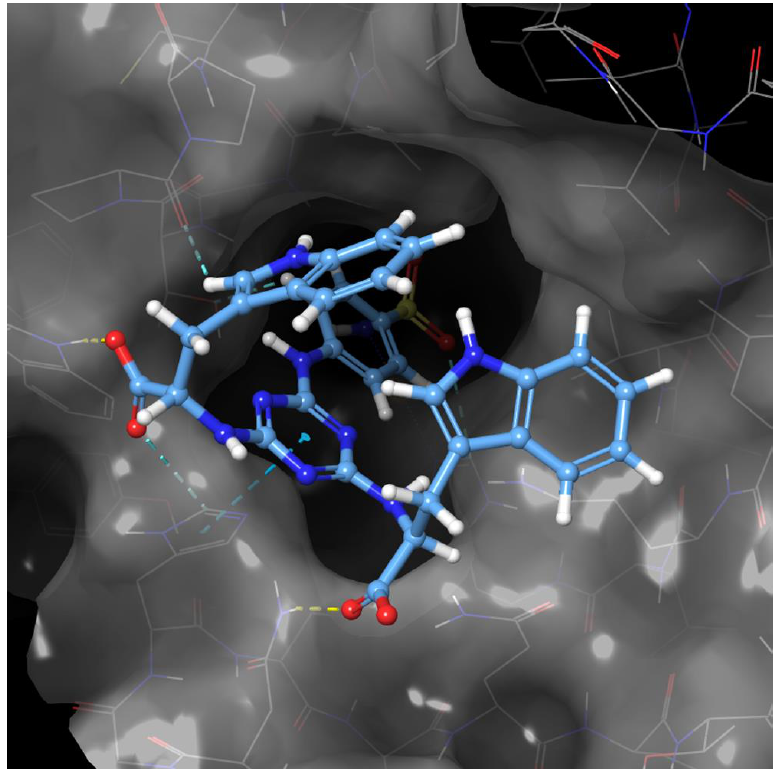
Figure 2. Intermolecular interactions of compound 6 (Trp derivative) docked into hCA II.